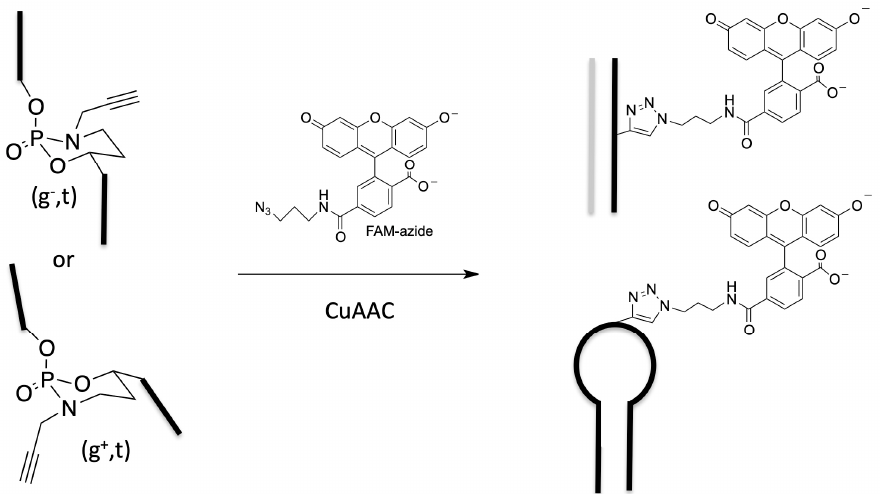
Figure 14. α , β -C 2 NA modified ONs conjugation with fluorescein for duplex or hairpin decoration. The ( R C5’ , R P )- α , β -C 2 NA featuring the gauche ( − ), trans configuration was a stabilizing